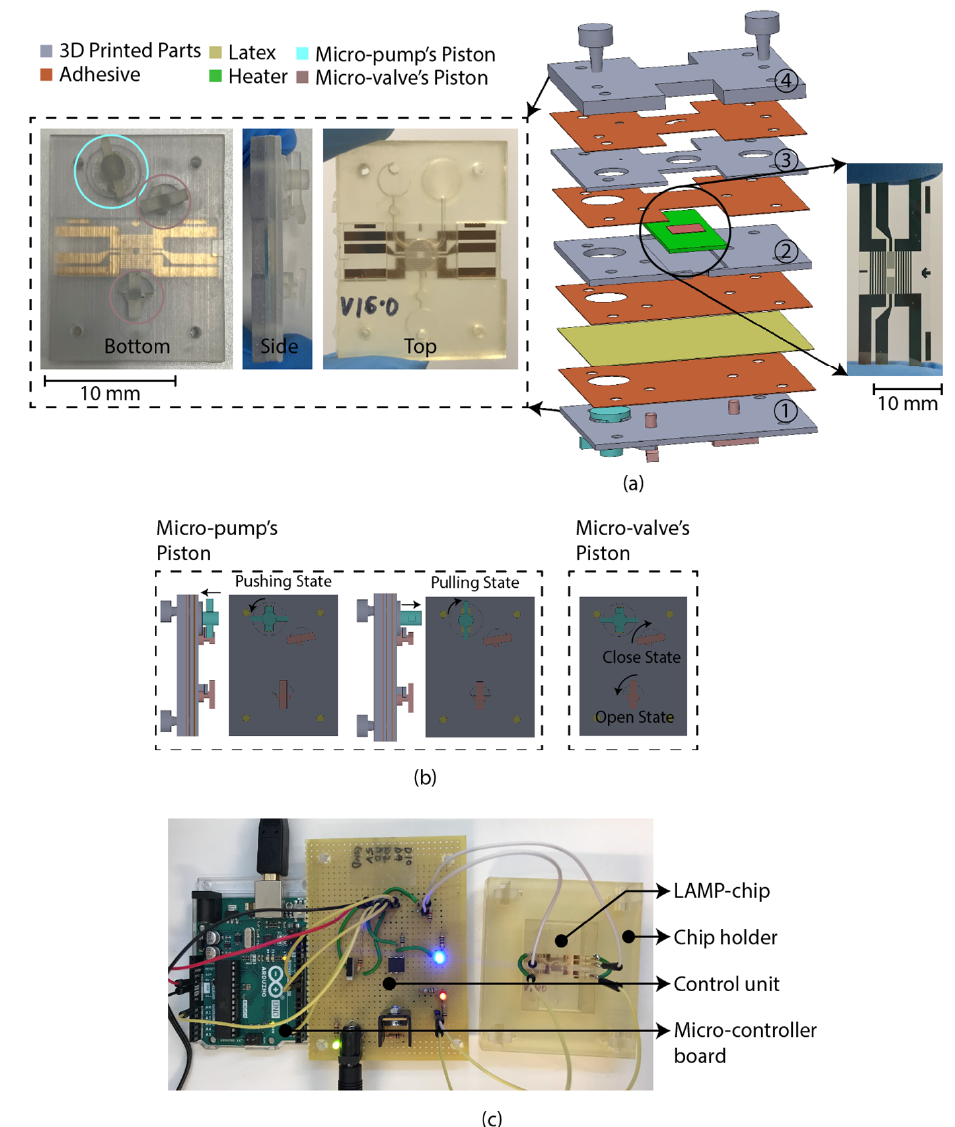
Figure 4. LAMP-chip ( a ) photo and exploded 3D schematic. The primary function of the four 3D-printed parts: (1) supports the pistons, (2) supports the heater, (3) chamber feature, (4) inlet-outlet feature. The latex membrane supports the functionality of the micro-pump and the micro-valve. ( b ) Micro-pump’s push-pull state and micro-valve’s open-close state. Anticlockwise rotation and push action are required to create positive pressure (pushing state). Clockwise rotation and pulling action are required to create negative pressure (pulling state). ( c ) Experimental setup consists of LAMP-chip with the chip holder and control circuit